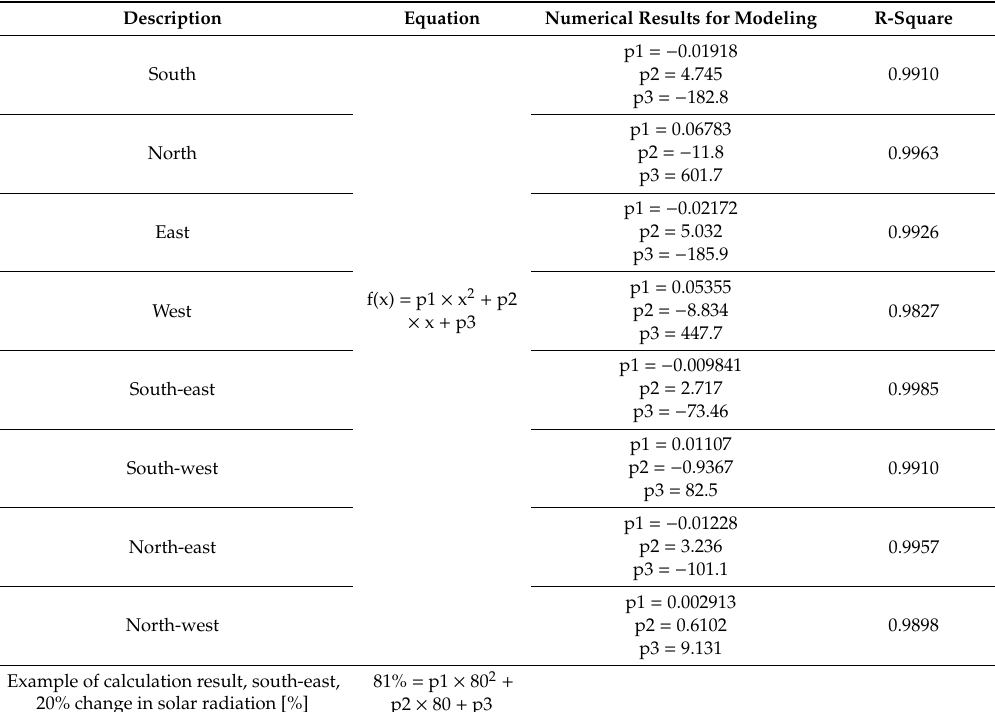
Table 4. The e ff ect of solar radiation changes on p-Si performance (x = change in solar radiation (%), FP = 100%, 80% = 20% change in solar radiation; f(x) = percentage value of the performance compared to the